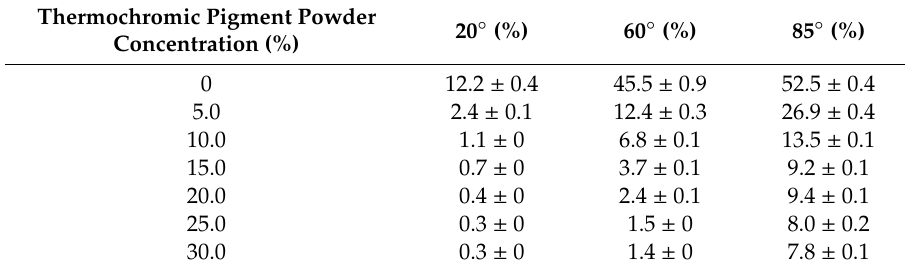
Table 4. Influence of different concentrations of the color-changing powder on the gloss of the primer film at 20°, 60°, and 85°.